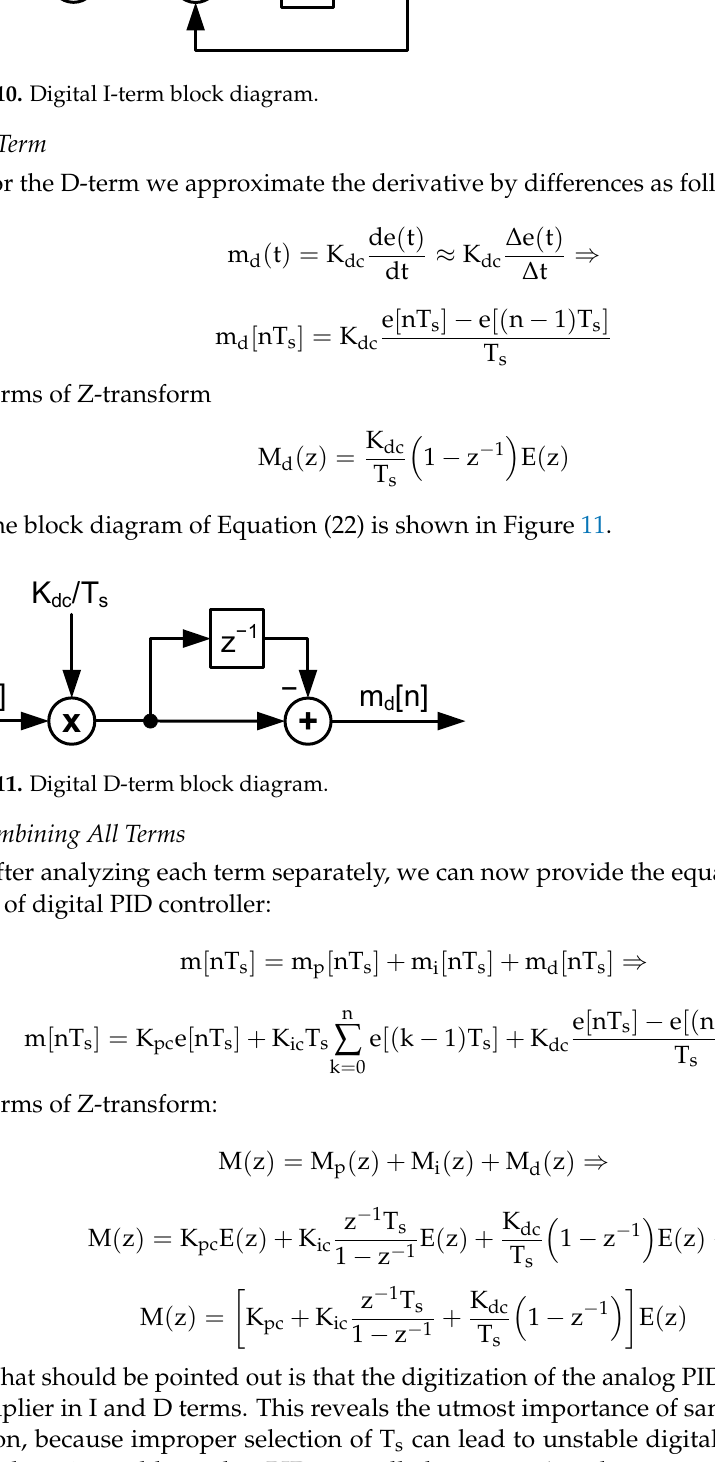
Figure 10. Digital I-term block diagram.